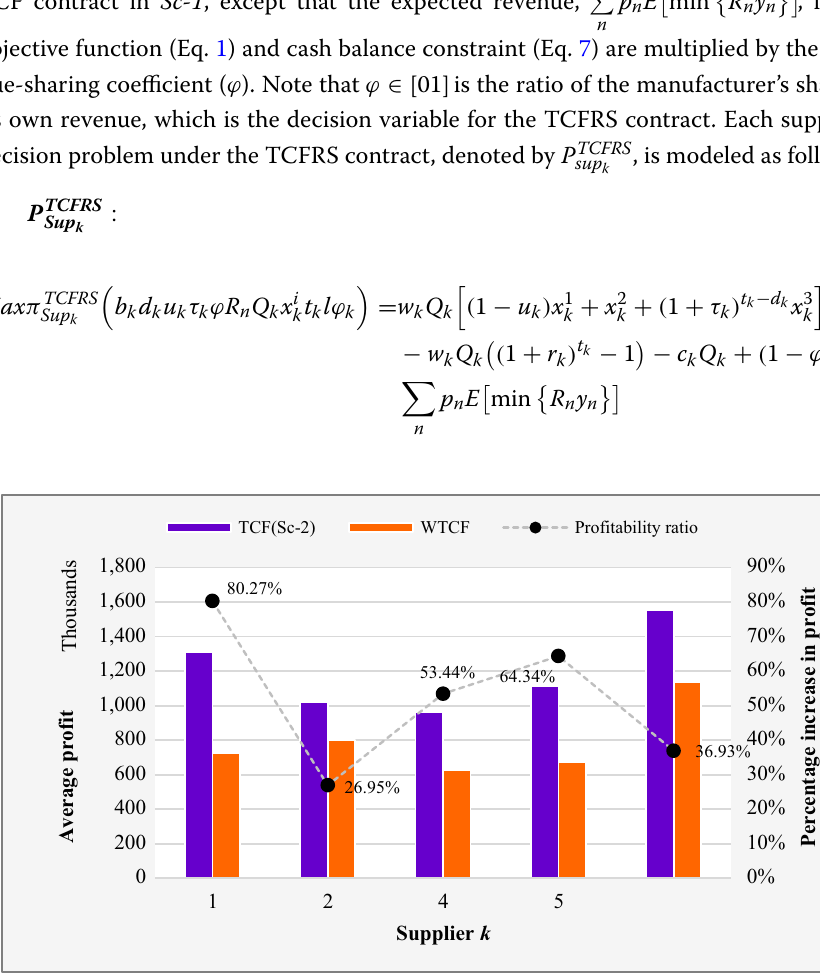
Fig. 8 The effects of TCF contract in Sc-2 on the supplier’s profit for test problems of size